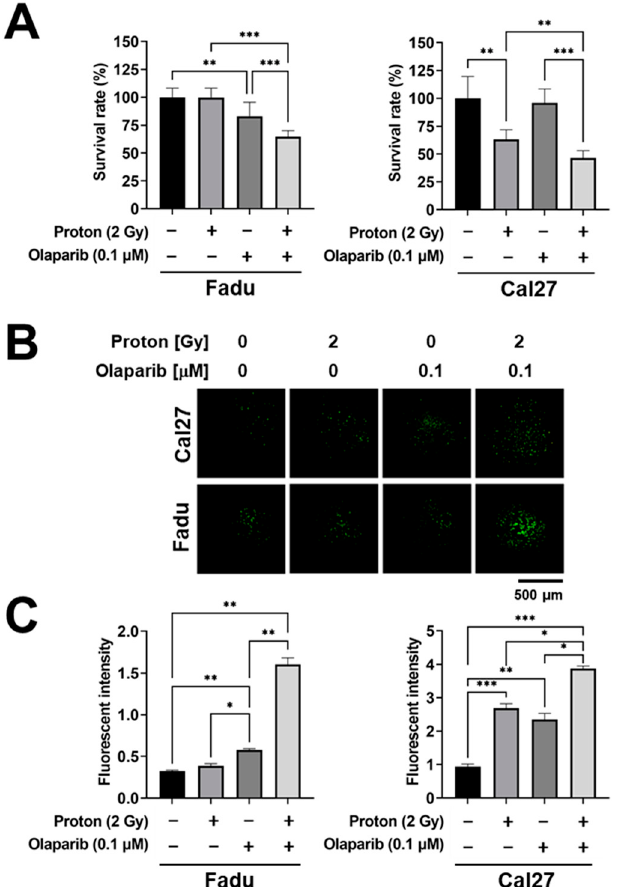
Figure 6. Effect of combination treatment with proton and olaparib on the apoptosis of HNSCC spheroids. ( A ) Comparison of survival rates of Fadu and Cal27 treated with 2 Gy of proton and 0.1 µ M olaparib. Data are mean ± S.D. ( n = 9). ( B ) Apoptotic cell death induced by the combination treatment with protons and olaparib as determined by caspase-3/7 detection assay. Representative fluorescent images of Cal27 and Fadu spheroids related to caspase-3/7 activity. ( C ) Quantification of fluorescence intensity showing an increase in apoptotic death of spheroids by the combination with proton and olaparib. Data are mean ± S.D. ( n = 3). * p < 0.05; ** p < 0.01; *** p < 0.001.